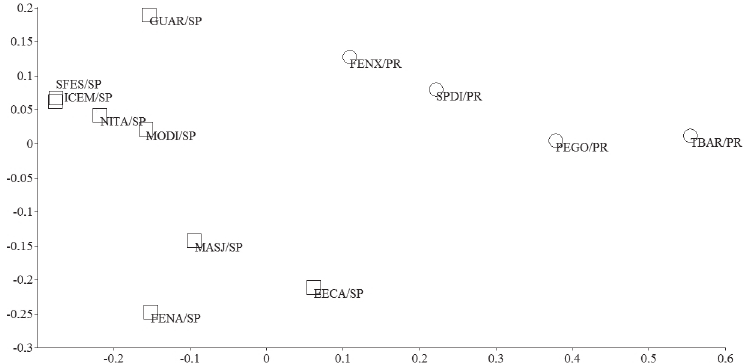
Figure 5 - Non-metric multidimensional scaling (nMDS) analysis according to Jaccard’s similarity matrix, considering the composition of anurans in areas inventoried within the MSF: SPDI – São Pedro do Ivaí (present study); FENX – Fênix (present study); TBAR – Três Barras do Paraná (Bernarde and Machado